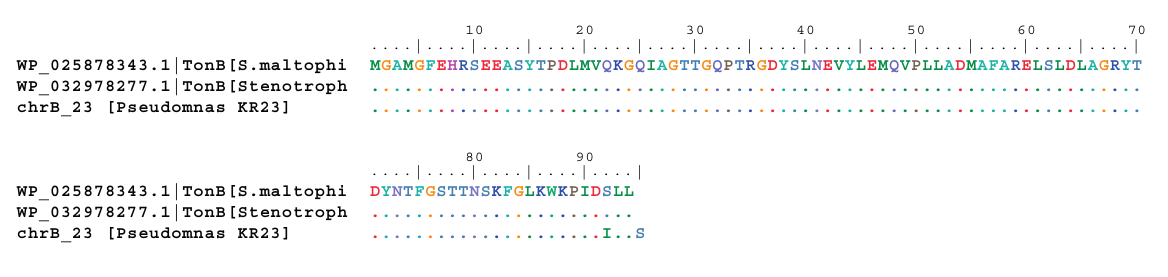
Figure 3. Alignment of the TonB protein from S. maltophila (WP033832814.1) and Stenotrophomonas sp. RIT309 (WP032978277.1) with the predicted chrB_23